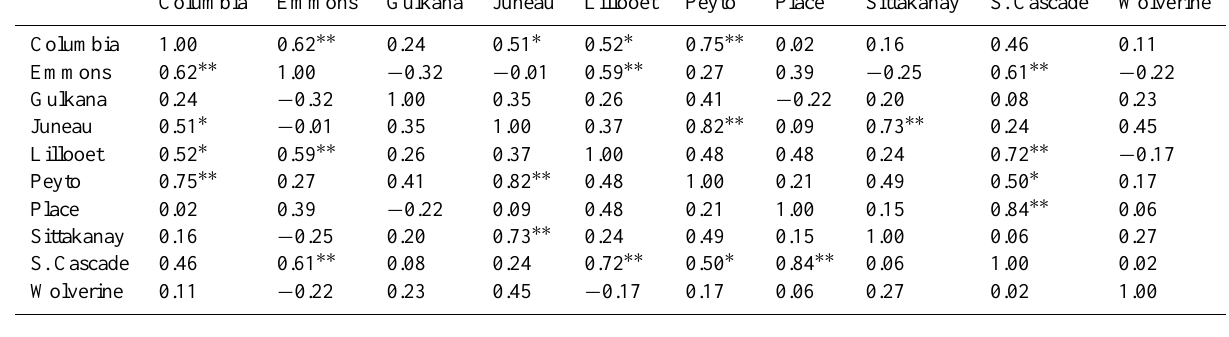
Table 6. Regional ELA anomaly correlation matrix. Correlations significant at p = 0.1 ( ∗ ) and p = 0.05 ( ∗∗ ) are noted. Columbia